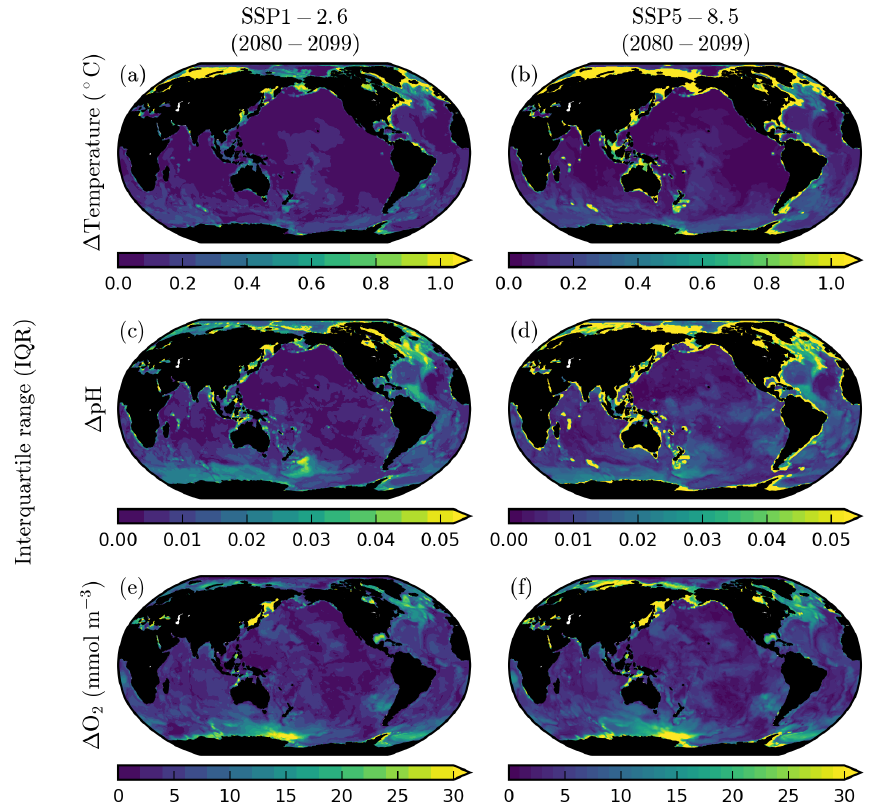
Figure A3. The interquartile range associated with CMIP6 projections of benthic impact drivers. The CMIP6 interquartile range ( Q 3 – Q 1 ) of projected anomalies in benthic (a, b) temperature ( ◦ C), (c, d) pH, and (e, f) dissolved O 2 concentration (mmolm − 3 ). The corresponding mean projections are given in Fig.